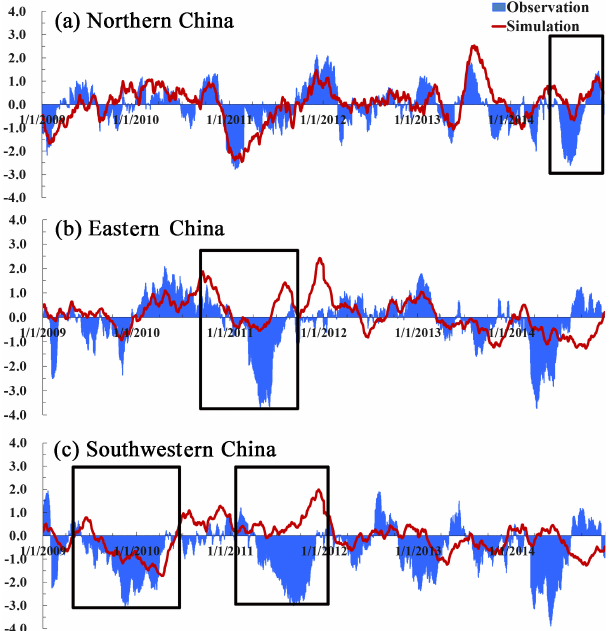
tionship is forced with the NCEP/NCAR reanalysis dataset.